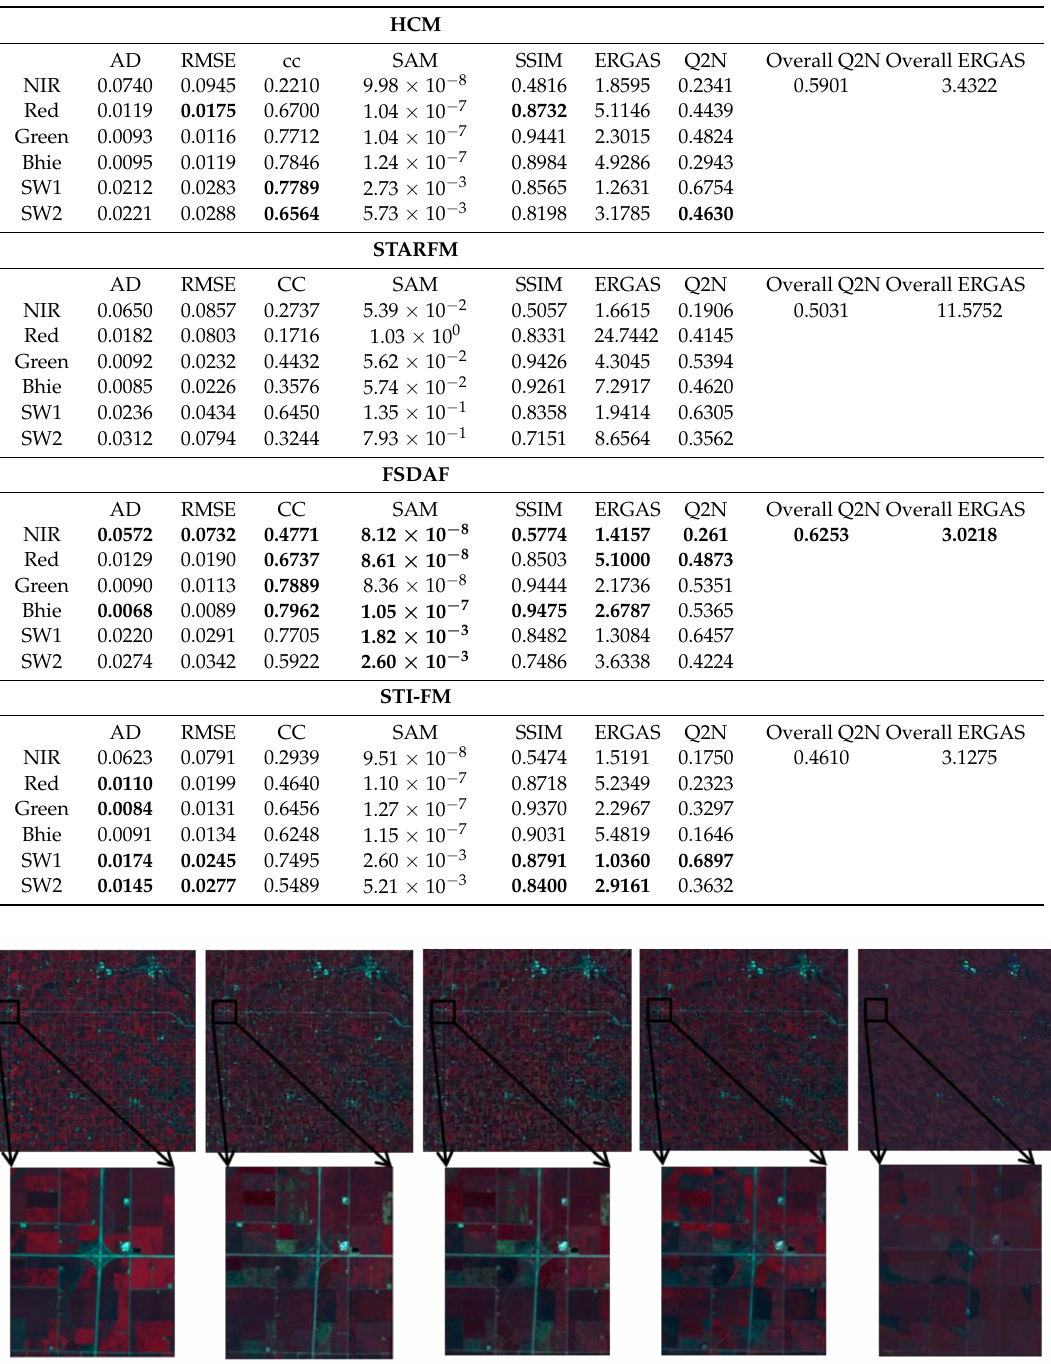
Table 5. Comparison of forward prediction results of using Landsat image 182 to predict Landsat image 214.